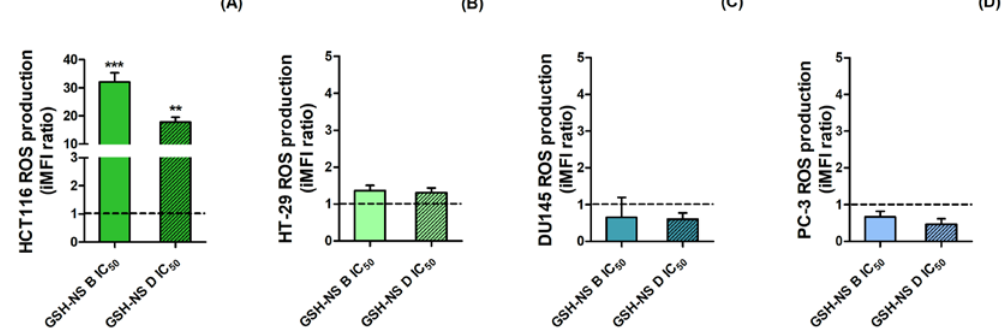
Figure 5. Glutathione responsive β -cyclodextrin-based nanosponge reactive oxygen species (ROS) production. HCT116 ( A ), HT-29 ( B ), DU145 ( C ), and PC-3 ( D ) cells were treated with GSH-NS B or GSH-NS D at the respective IC 50 for 24 h. ROS levels, detected by dichlorofluorescein-diacetate (DCFH-DA) assay by flow cytometry, were expressed as the integrated median fluorescence intensity (iMFI) ratio and nanosponge-induced ROS levels were compared to those of control, that is, untreated cells, fixed at 1 and shown by the dotted line. Statistically significant difference versus untreated cells: ** p < 0.01; *** p < 0.001.